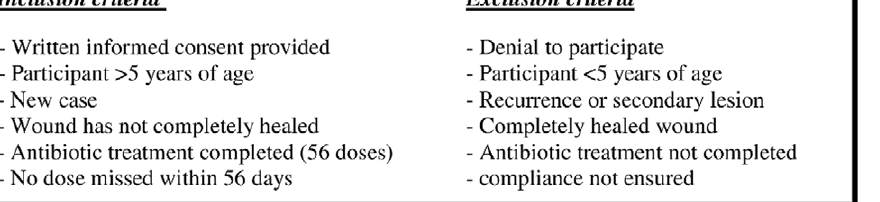
Table 3. Primers and probes.